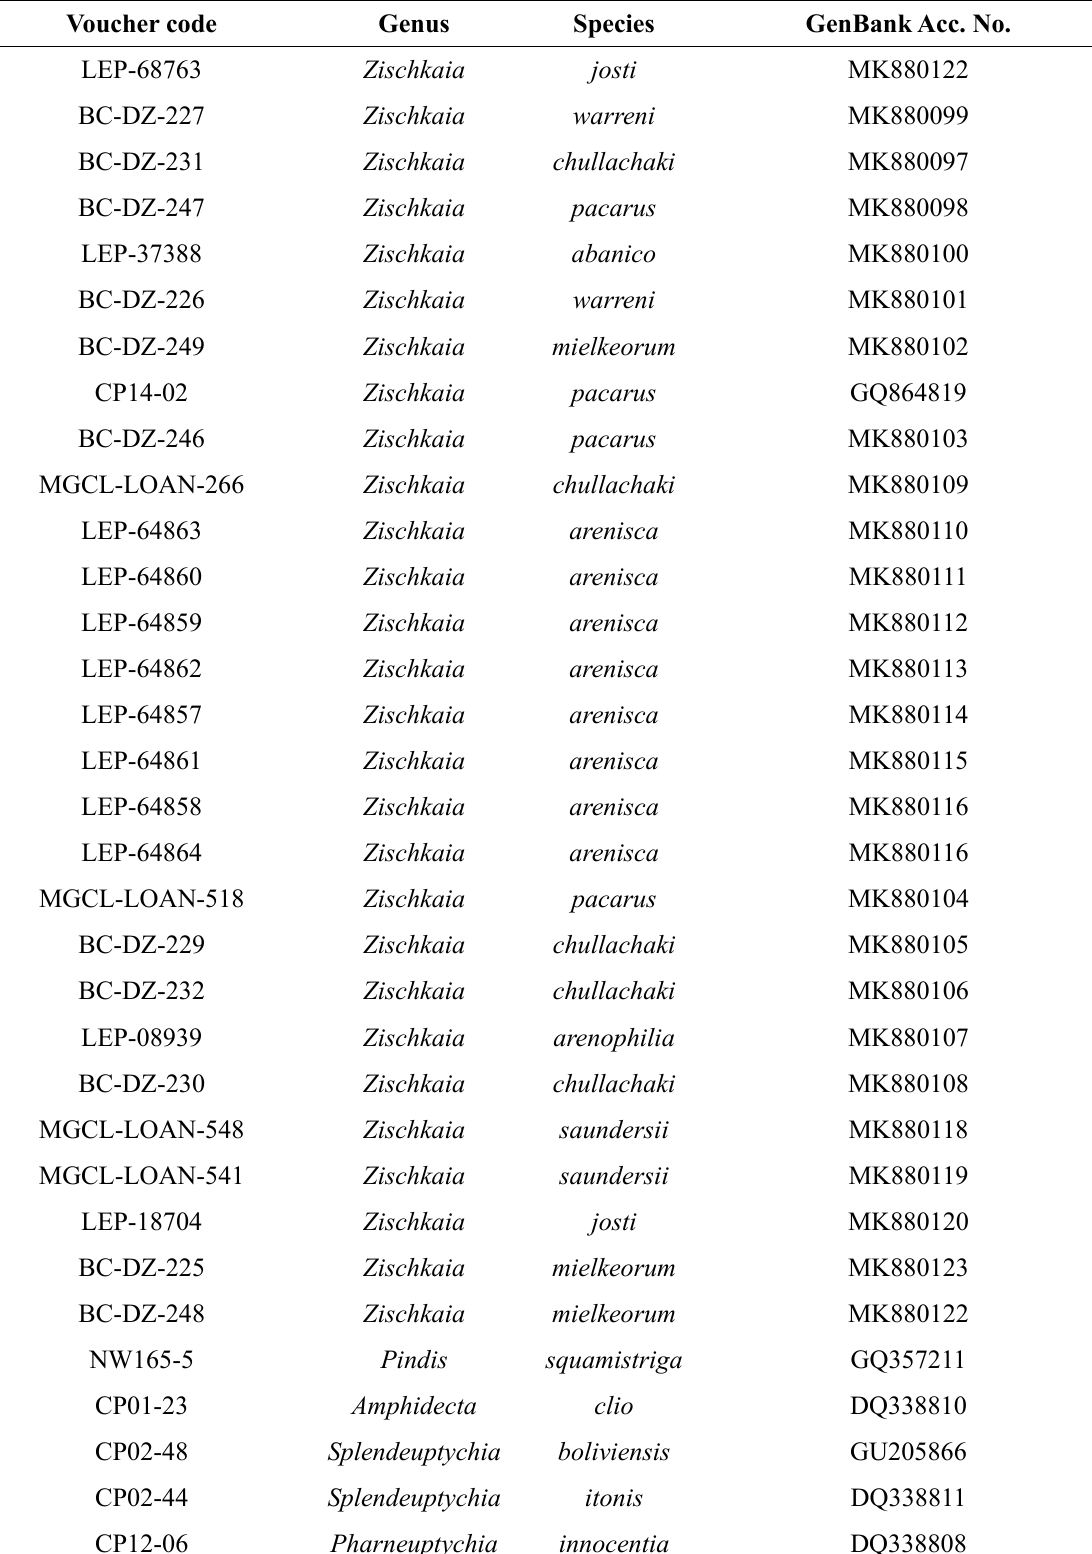
Table 3. GenBank accession numbers for specimens used for molecular analysis in this